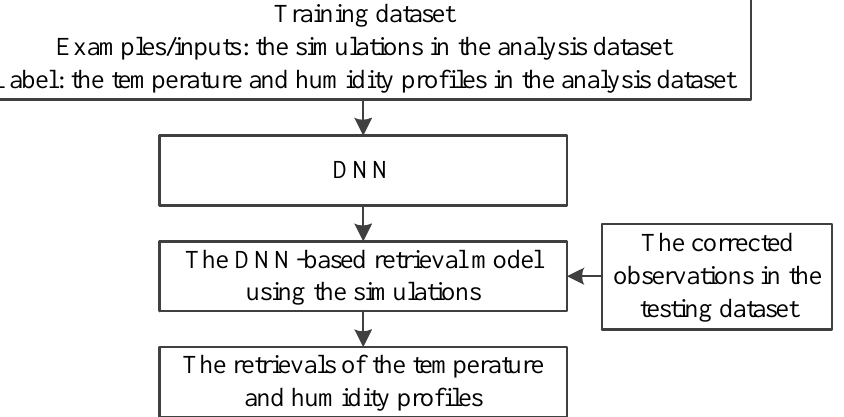
Figure 4. The schematic of the retrieval based on the DNN-based retrieval model using the simula- tions.